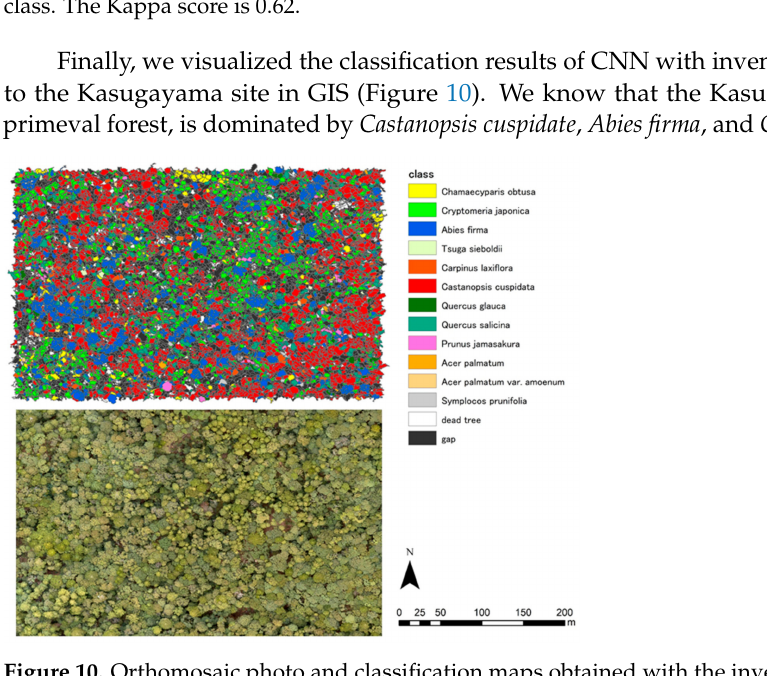
Figure 10. Orthomosaic photo and classification maps obtained with the inventory tuning CNN in the Kasugayama site. The CNN model was trained from a dataset of different sites. The area is 12